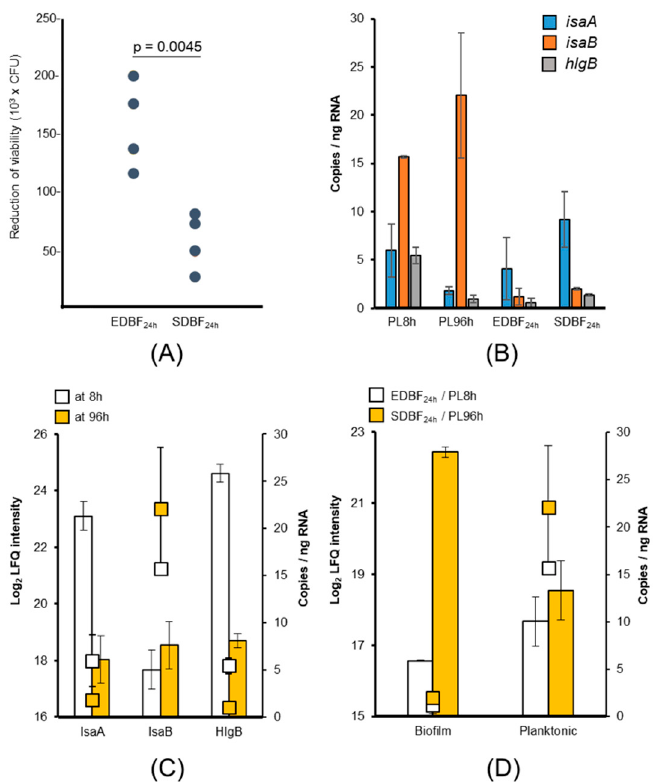
Figure 4. ( A ) THP-1-mediated phagocytosis / intra-cellular killing of the fully matured EDBF and SDBF cells at three and 24 hpi. Biofilm cells were detached from the polystyrene support and washed prior to the in vitro test. An unpaired t -test was used to compare the means of both groups. ( B ) Relative abundances of isaA , isaB, and hlgB specific transcripts in the PL8 h, PL96 h, EDBF_24 h, and SDBF_24 h cells. ( C ) Relative transcript (squares) versus the protein abundance (bars) levels for IsaA, IsaB, and HlgB in planktonic bacteria at 8 and 96 h time points. ( D ) Relative transcript (squares) versus protein abundance (bars) levels for IsaB during planktonic and biofilm growth. The error bars in panels B, C, and D indicate standard deviations for ≥ 2 protein label-free quantification (LFQ) intensity values and relative transcript abundances of two independent ddRT-PCR assays.